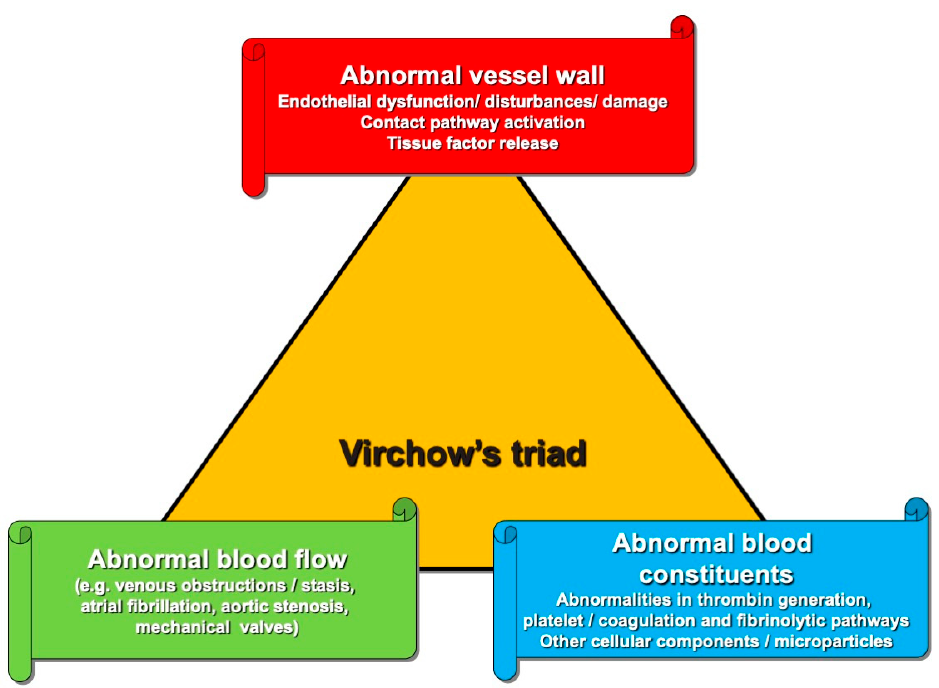
Figure 2. Virchow’s triad. Thrombosis can occur due to the disruption of any of the three components listed.